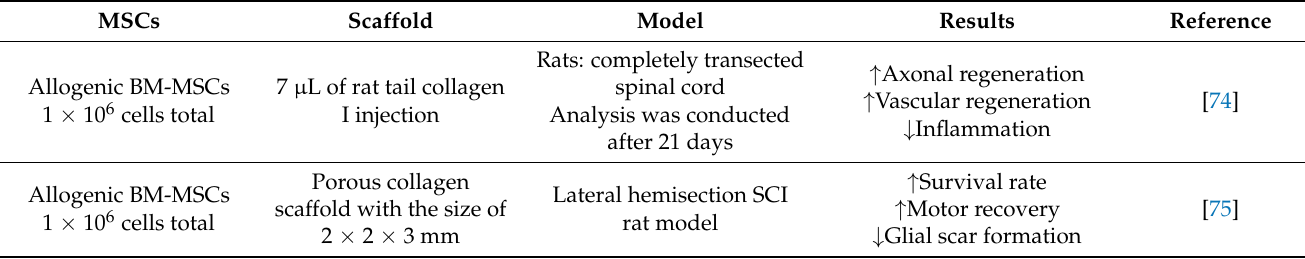
Table 1. Overview of the studies evaluating biochemical and cellular changes using MSC-enriched collagen scaffolds in in vivo SCI